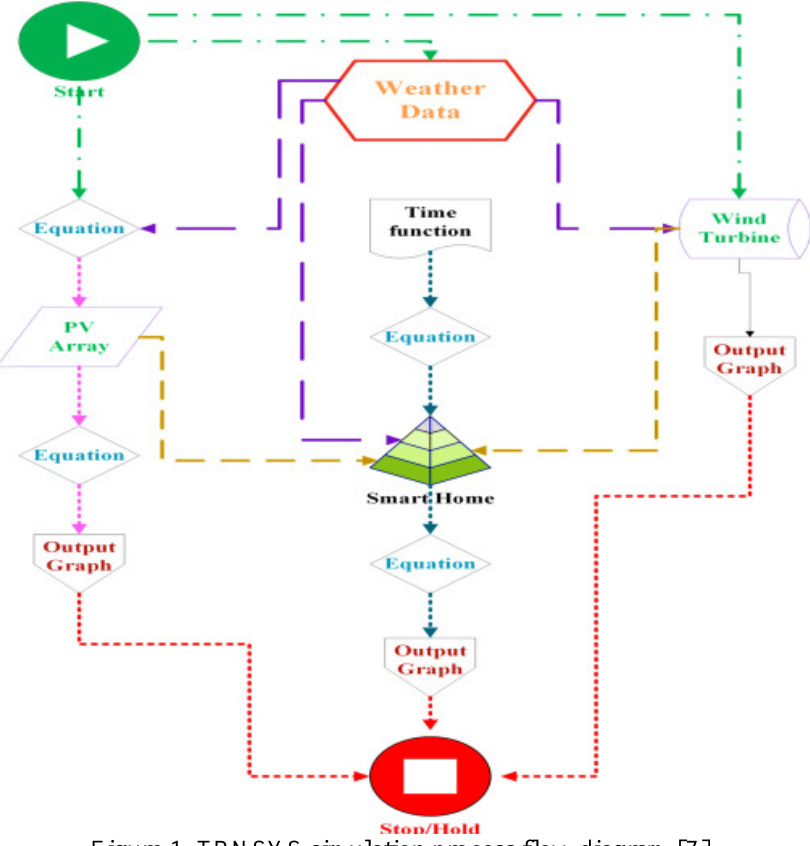
Figure 1. TRNSYS simulation process flow diagram